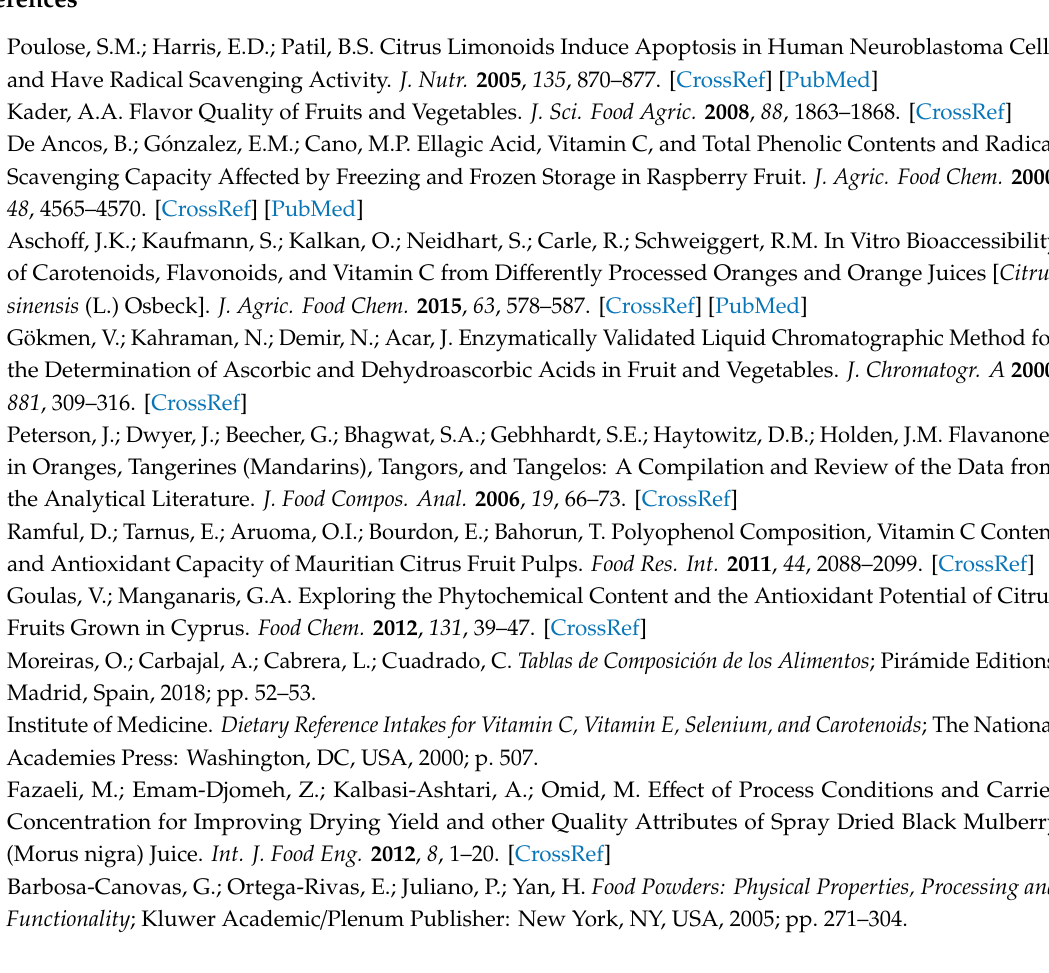
Table S1: Values (mean ± SD) of the di ff erent physicochemical properties evaluated. All acronyms used are described in the main text. Table S2: Percentage (mean ± SD) of the bioactive compounds preserved in the FDP for each condition evaluated. All acronyms used are described in the main text. Table S3: Values (mean and Tukey’HSD classification) of the di ff erent physicochemical properties and bioactive compounds evaluated for: each individual factor (a–c), the interaction between two di ff erent factors (d–f) and for the interaction between the three factors studied (g). All acronyms used are described in the main text. Table S4: Variable importance in the PLS-R Projection (VIP). VIP > 1 are considered as the most important variables for the model. All acronyms used are described in the main